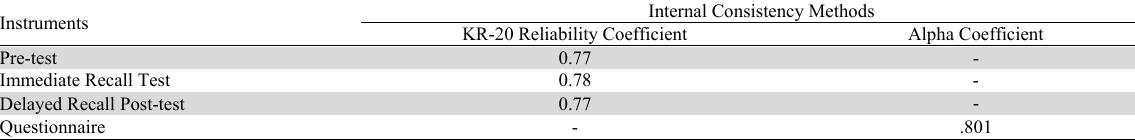
Internal Consistency of Instruments Used in the